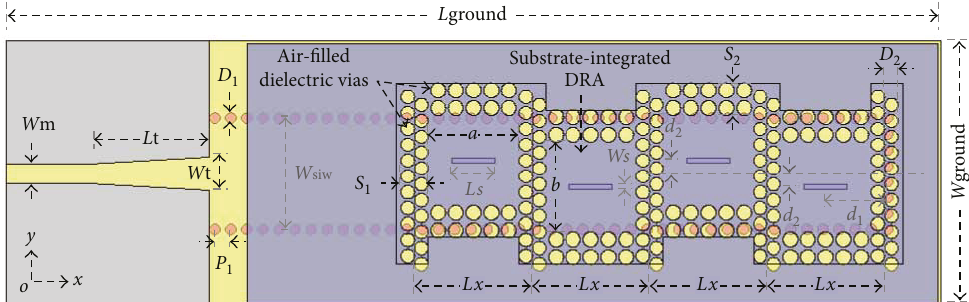
Figure 4: Structure of the proposed linear SIDRAA.